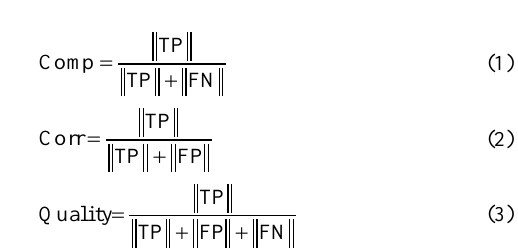
Figure 4. Illustration of determining TP, FP, and FN